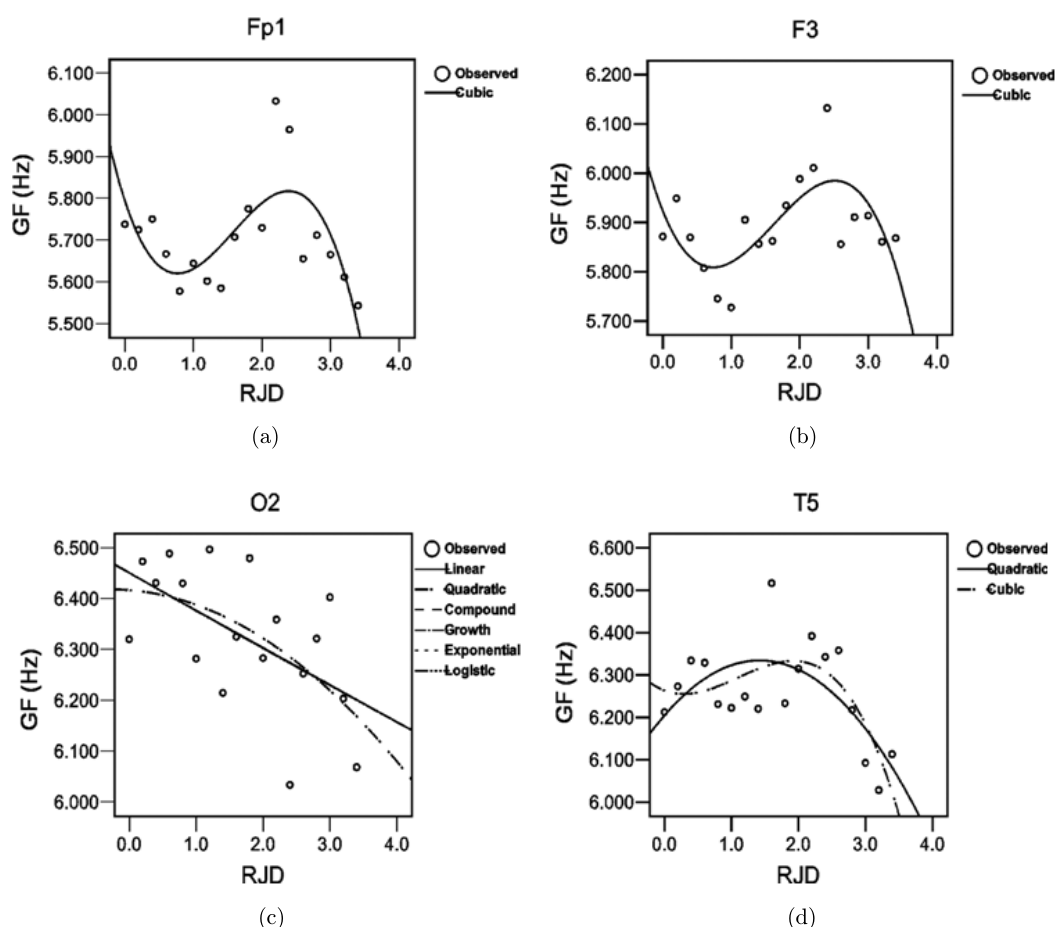
Fig. 3. The curve ¯tting of GF to RJD in di®erent channels of (a) Fp1, (b) F3, (c) O2, (d) T5. The x -axis represents the variation of RJD and the y -axis represents